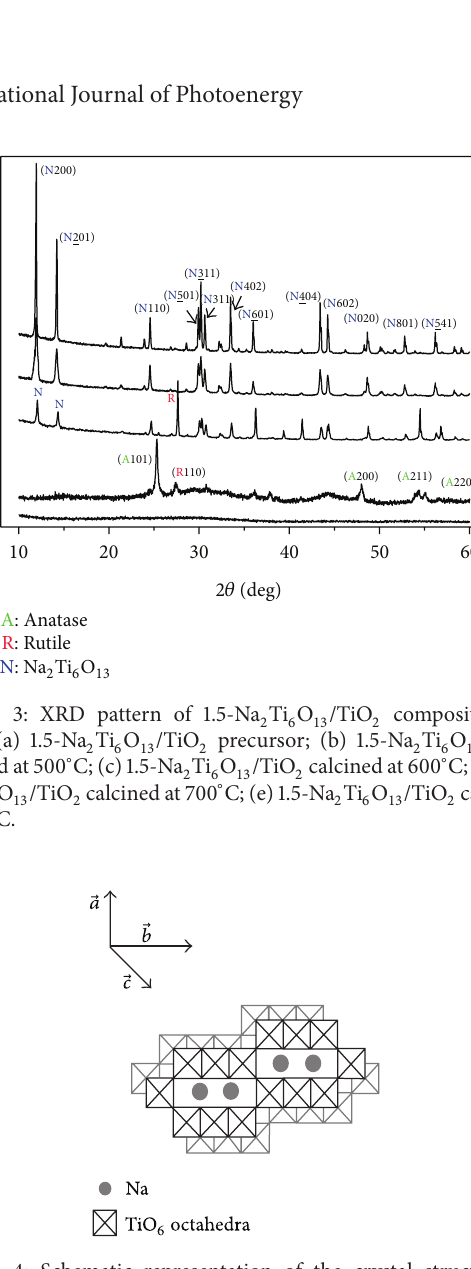
Figure 4: Schematic representation of the crystal structure of Na 2 Ti 6 O 13 along 𝑎 -axis [31] (octahedral: Ti–O 6 ; spheres: Na).